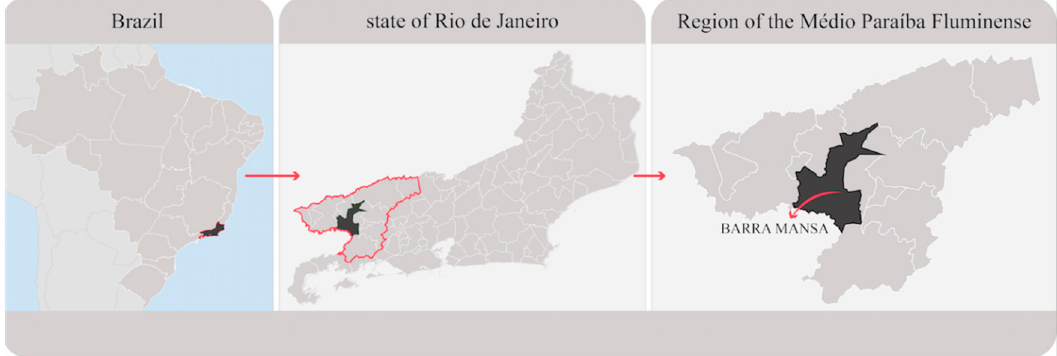
Figure 1. Maps of Brazil, the state of Rio de Janeiro, and the Region of Médio Paraíba Fluminense with emphasis on the municipality of Barra Mansa. Source: Elaborated by the authors from IBGE—Instituto Brasileiro de Geografia e Estat í stica (or Brazilian Institute of Geography and Statistics) [54].